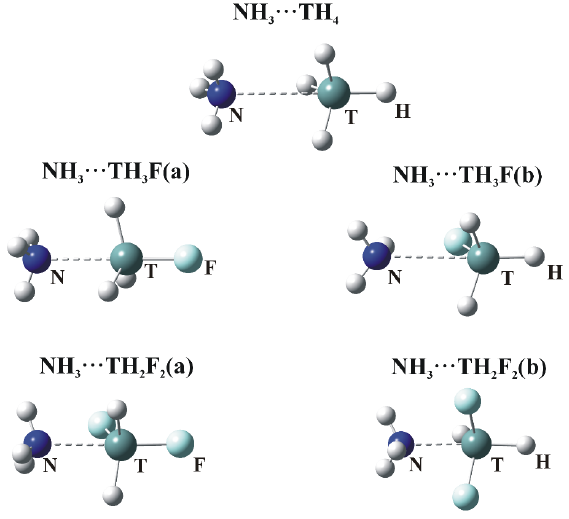
Figure 3. Optimized structures of σ -hole bonded tetrel complexes. ( a ) and ( b ) refer to σ -hole positions in Figure 1 (N—dark blue, T—green, H—white, F—Light blue). Table 3. Interaction energy (E int ) corrected for BSSE, of indicated Lewis acid with NH 3 in σ -hole bonded complexes, along with deformation energy (E def ) of individual subunits, intermolecular distance and angle (energies in kcal/mol, distances in Å, angles in degrees). Data obtained at the MP2 level of theory. Lewis Acid E int E def A a E def B b R(N ··· T) θ (R–T ··· N) c SiH 4 −